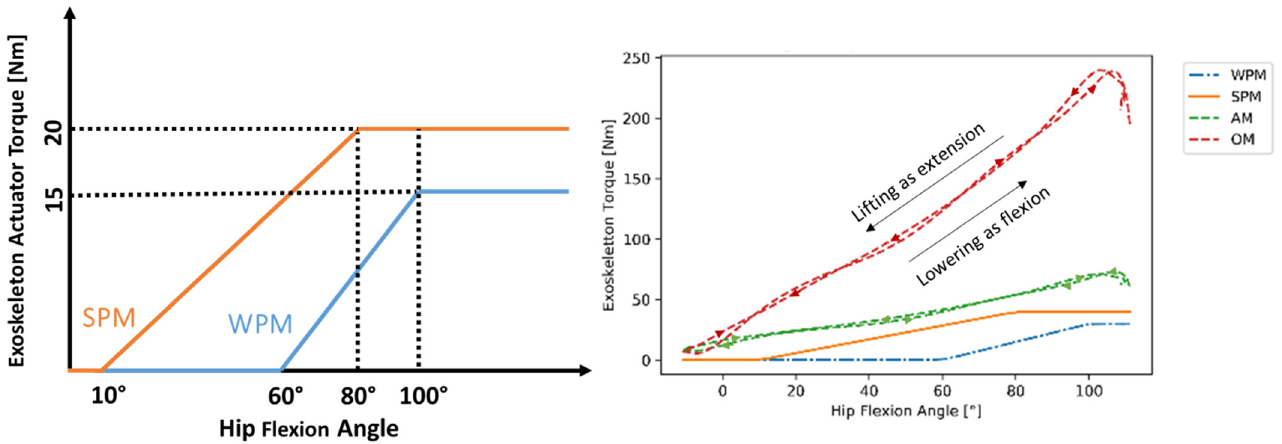
Figure 4. Characteristic torque–angle curves for WPM, SPM ( left graph), and all modes, including summed torque for both actuators for a symmetric, free-squat motion with 20 kg over flexion and extension phase ( right graph).